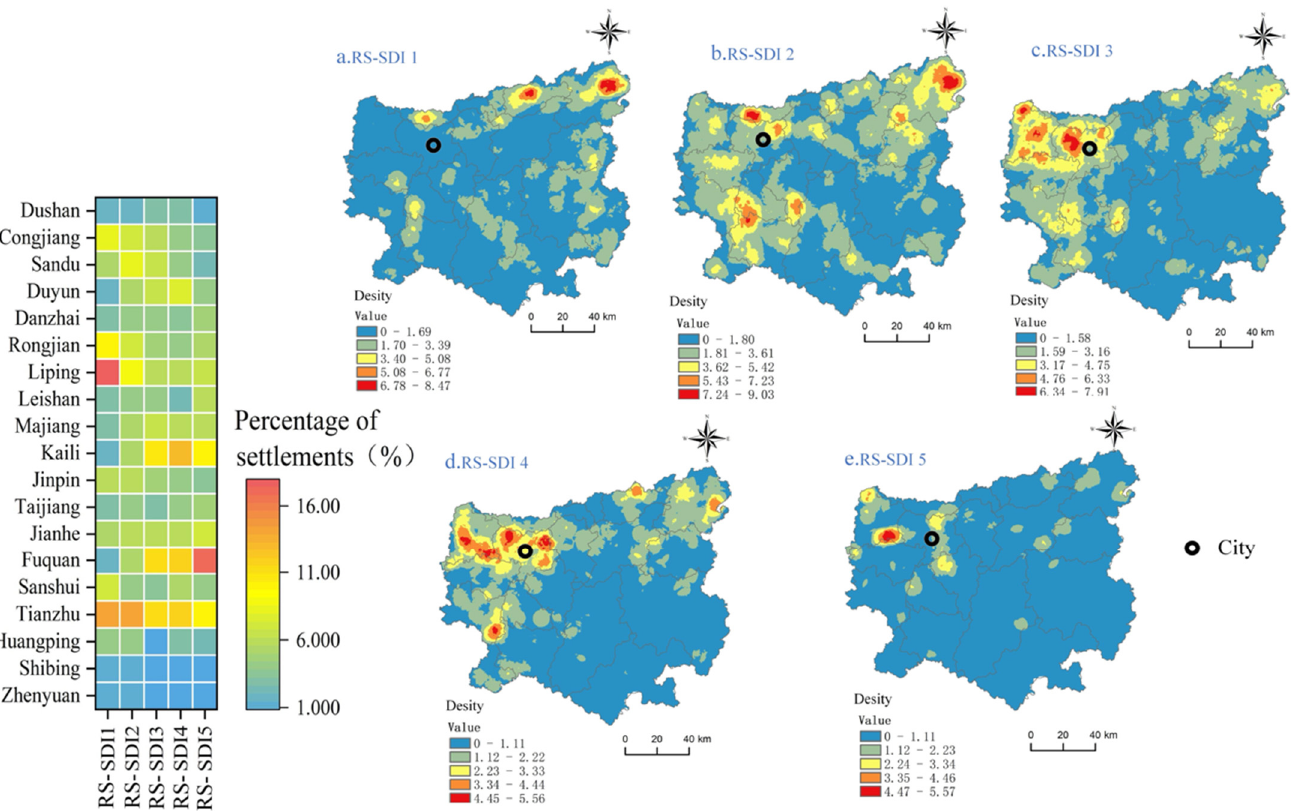
Figure 4. Spatial location characteristics of settlement distribution at different levels of sustainable development. (Note: the left shows the proportion of settlements within the county for different RS-SDI; the maps on the right, a-e, show the spatial distribution of settlements for different RS-SDI).